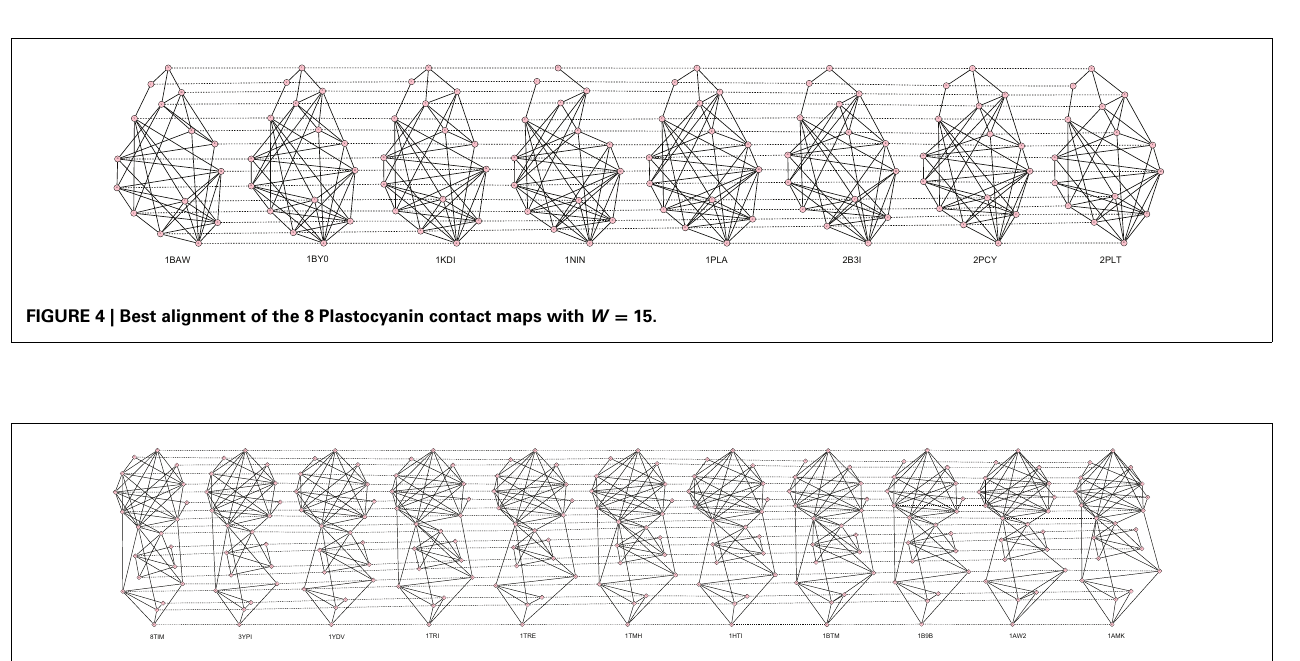
FIGURE 5 | Best alignment of the 11 TIM Barrel contact maps with W = 20.